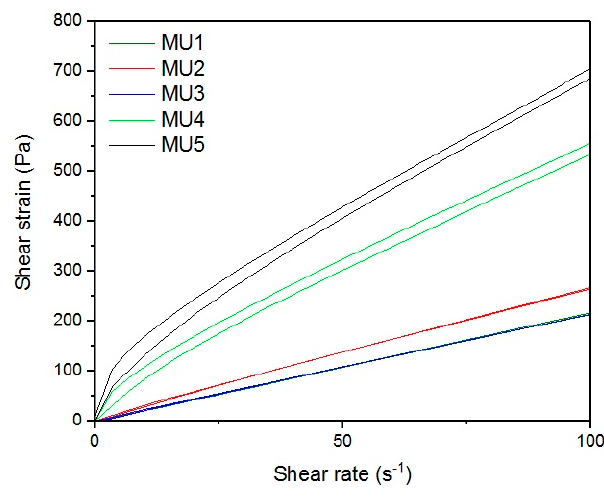
Figure 15. The shear strain-shear rate relations for all prepolymers at CSR = 100 s − 1 .